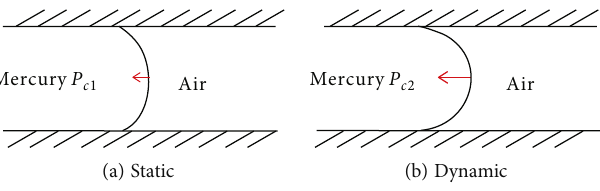
Figure 4: Schematic diagram of dynamic and static capillary